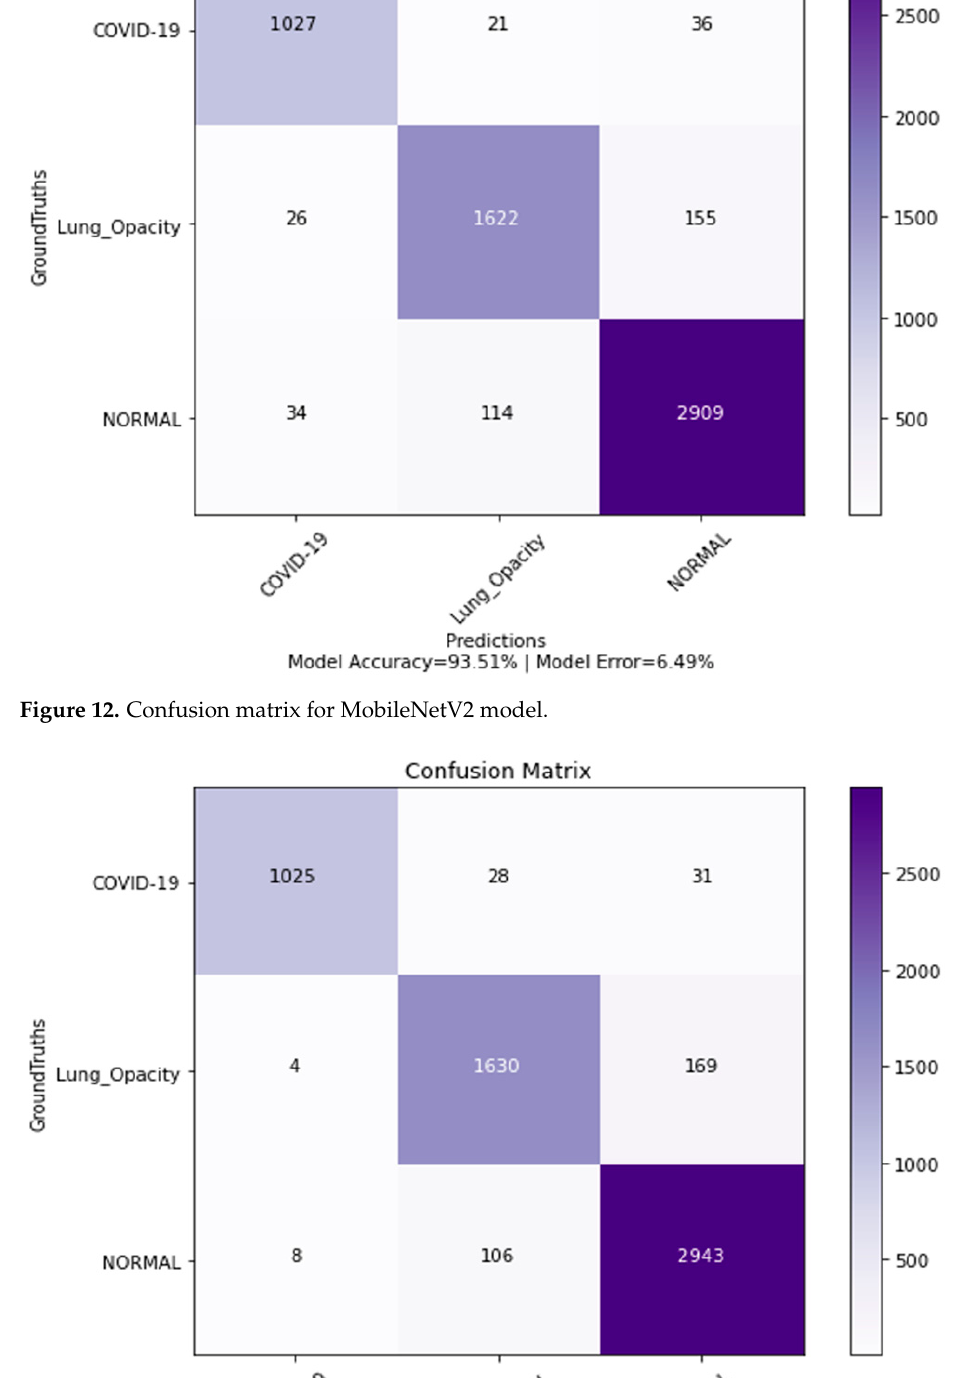
Figure 13. Confusion matrix for Xception model.